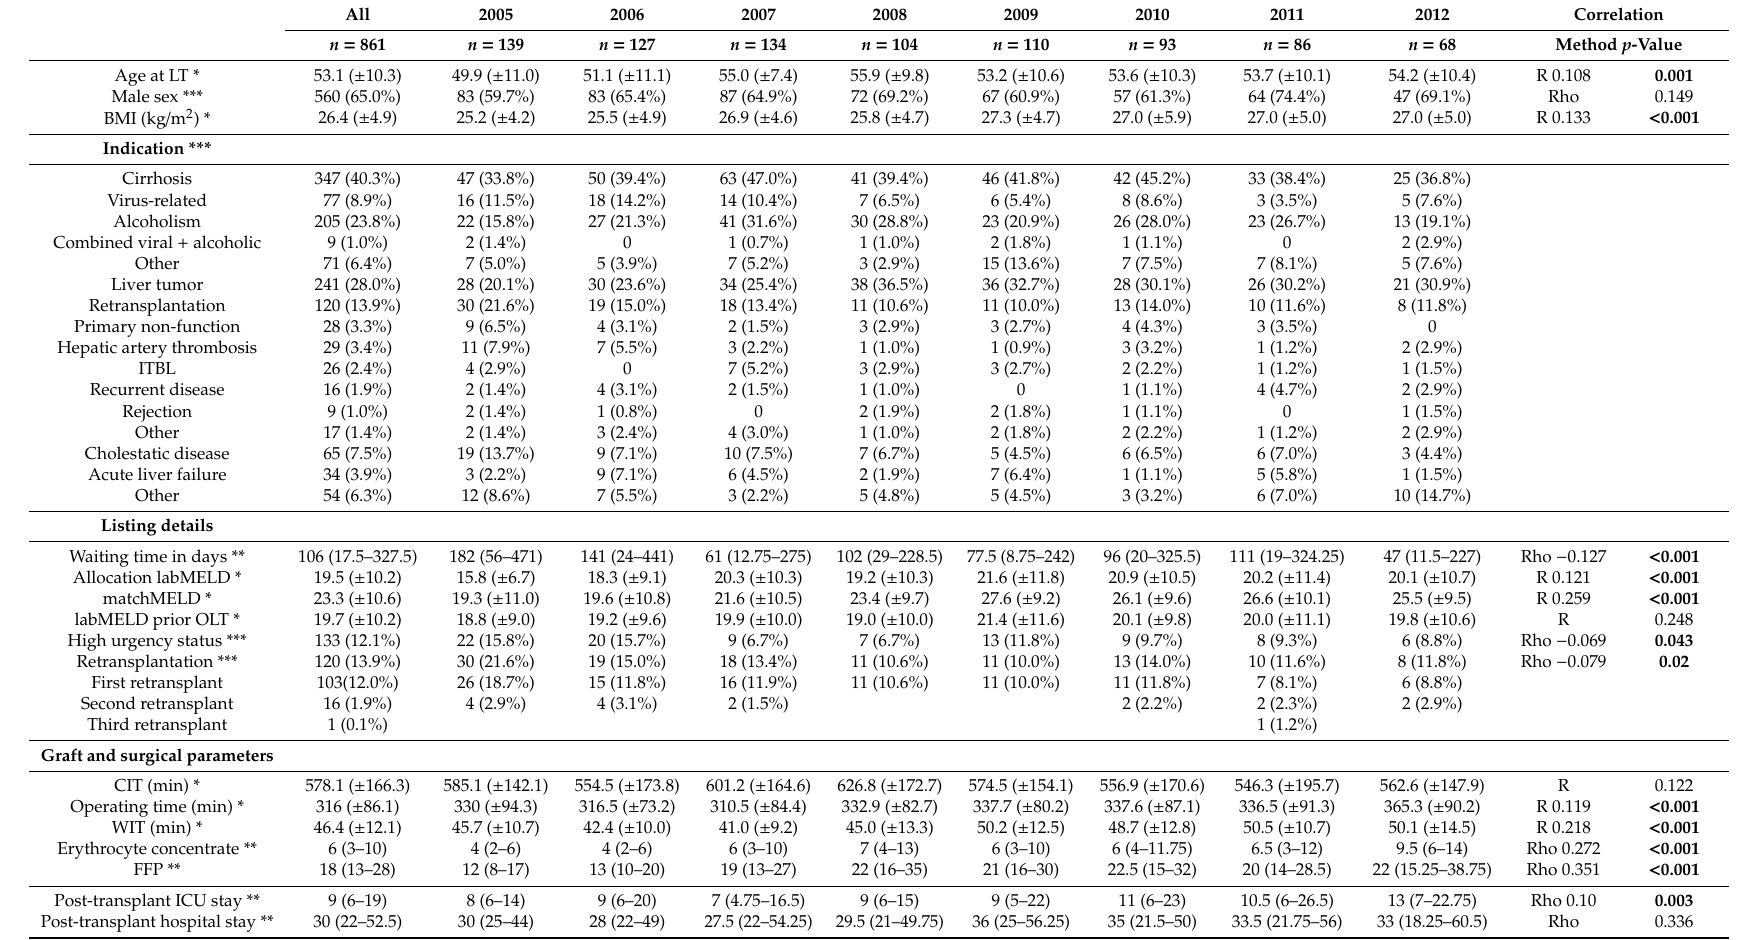
Table 1. Patient and donor